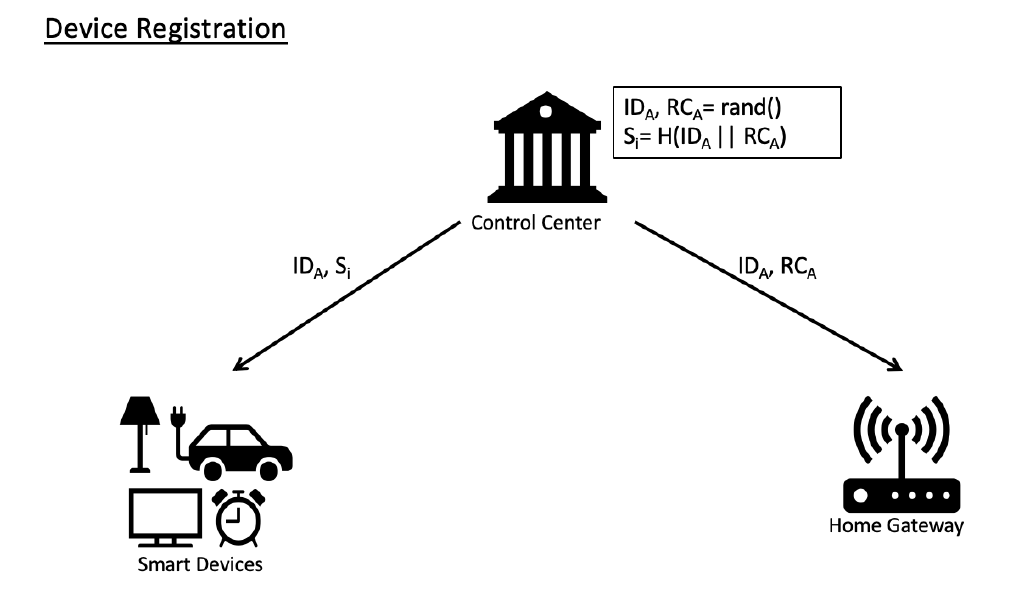
Figure 2. Illustration of device registration